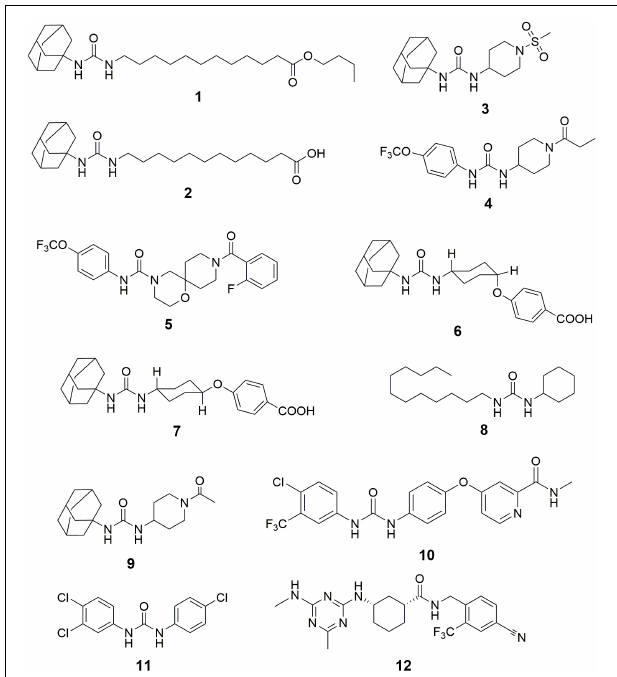
FIGURE 3 | The chemical structures of the inhibitors of sEH summarized in this paper. 1, n-butyl ester of 12-(3-adamantan-1-yl-ureido)-dodecanoic acid (nbAUDA); 2, 12-(3-adamantan-1-yl-ureido)-dodecanoic acid (AUDA); 3, 1-adamantan-1-yl-3-(1-methylsulfonyl-piperidin-4-yl-urea) (AR9273); 4, 1-trifluoromethoxyphenyl-3-(1-propionylpiperidin-4-yl)urea (TPPU); 5, 9-(2-fluorobenzoyl)-N-[4-(trifluoromethoxy)phenyl]-1-oxa-4,9- diazaspiro[5.5]undecane-4-carboxamide; 6, cis -4-[4-(3-adamantan-1-yl-ureido)cyclohexyloxy]benzoic acid ( c -AUCB); 7, trans -4-[4-(3-adamantan-1-yl-ureido)cyclohexyloxy]benzoic acid ( t -AUCB); 8, 1-cyclohexyl-3-dodecylurea (CDU); 9, 1-(1-acetypiperidin-4-yl)-3-adamantanylurea (AR9281); 10, 4-[4-[[4-chloro-3-(trifluoromethyl)phenyl]carbamoylamino]phenoxy]-N-methyl- pyridine-2-carboxamide (Sorafenib); 11, 3-(4-Chlorophenyl)-1-(3,4-dichlorophenyl)urea (Triclocarban); 12, (1R,3S)-N-[4-cyano-2-(trifluoromethyl)benzyl]-3-[(4-methyl-6-(methylamino)- 1,3,5-triazin-2-yl)amino] cyclohexane-1-carboxamide